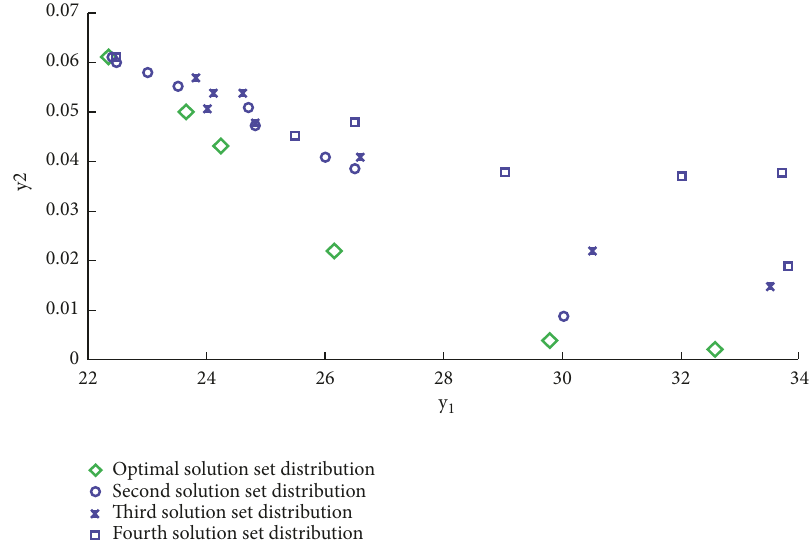
Figure 4: Distribution of Pareto optimal solutions and other solutions.